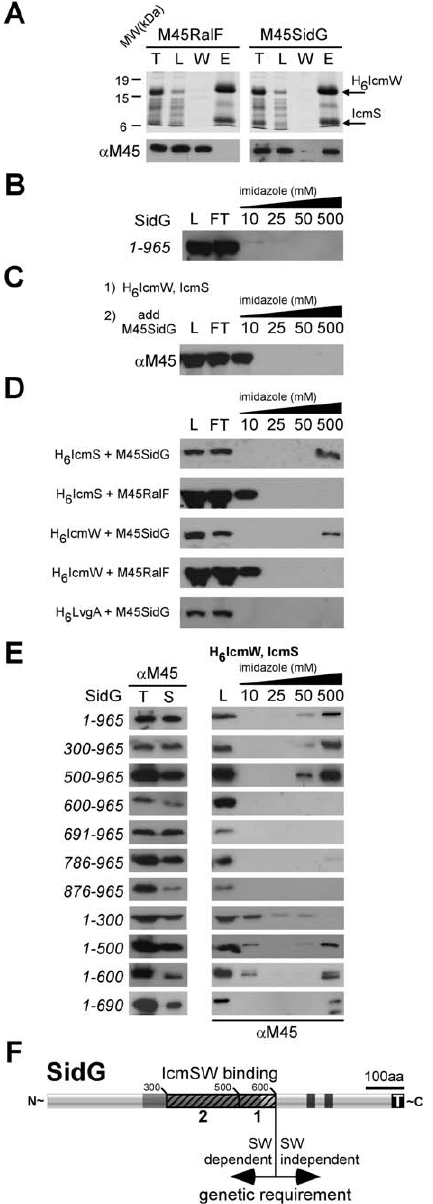
Figure 5. IcmSW Complex Binds to a Region of SidG That Is Distinct from the C-Terminal Translocation